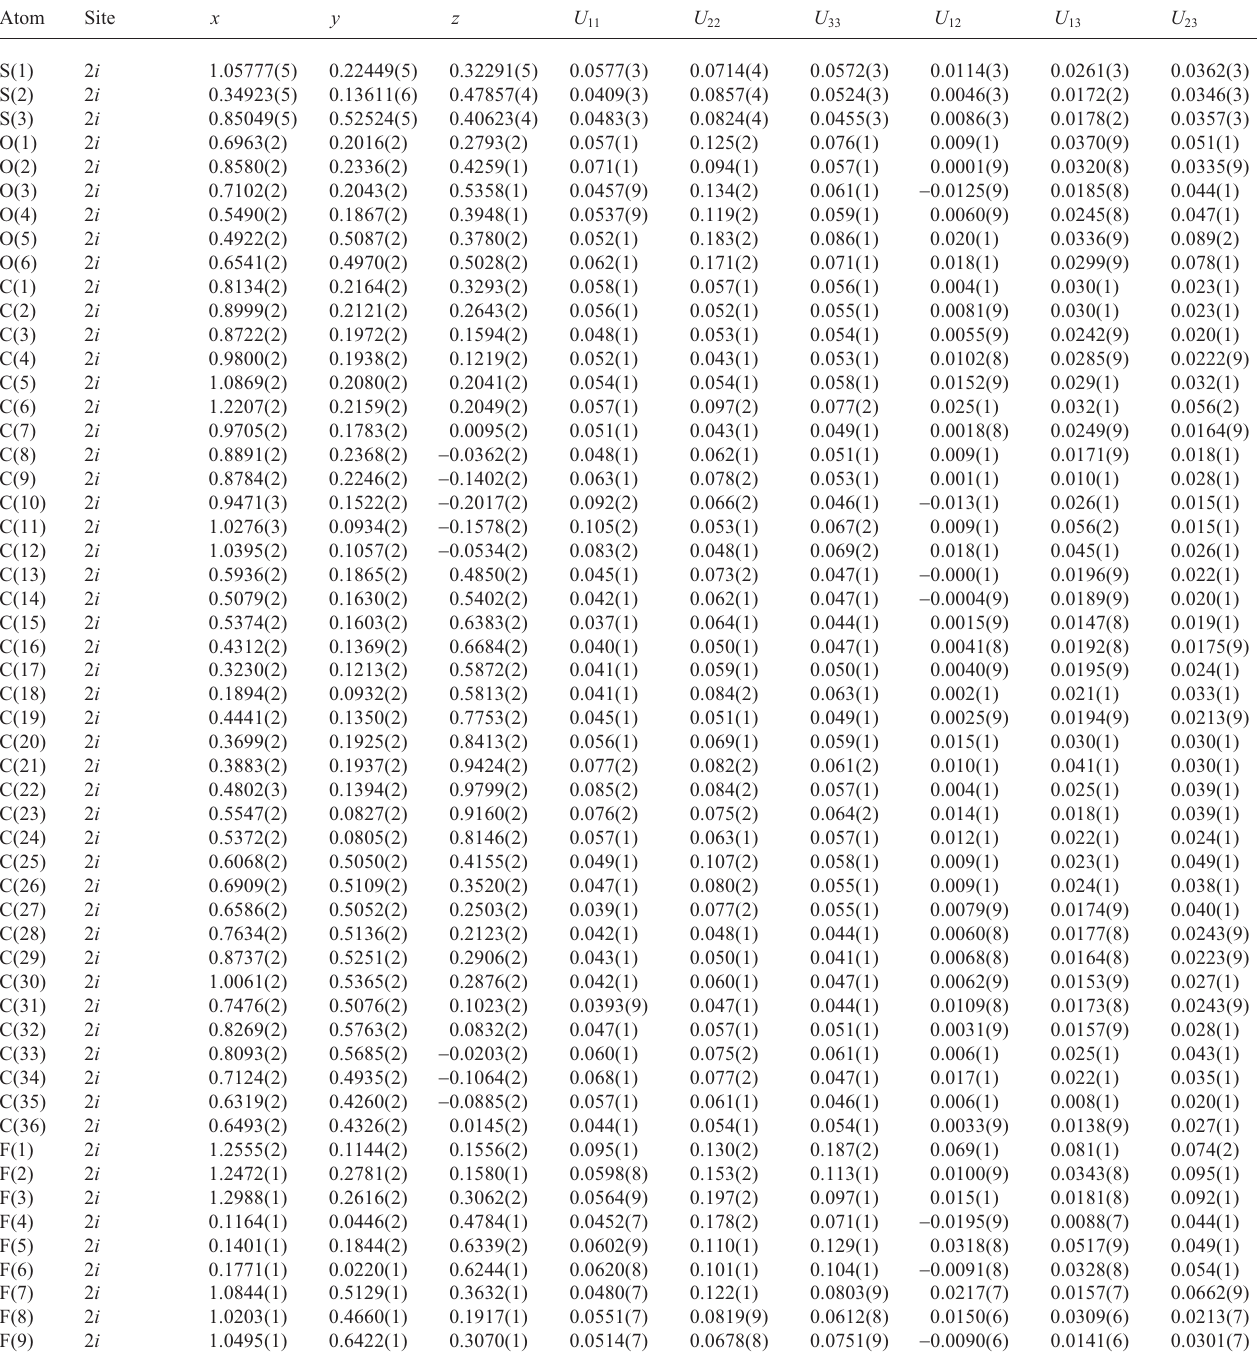
Table 3. Atomic coordinates and displacement parameters (in Å 2 )